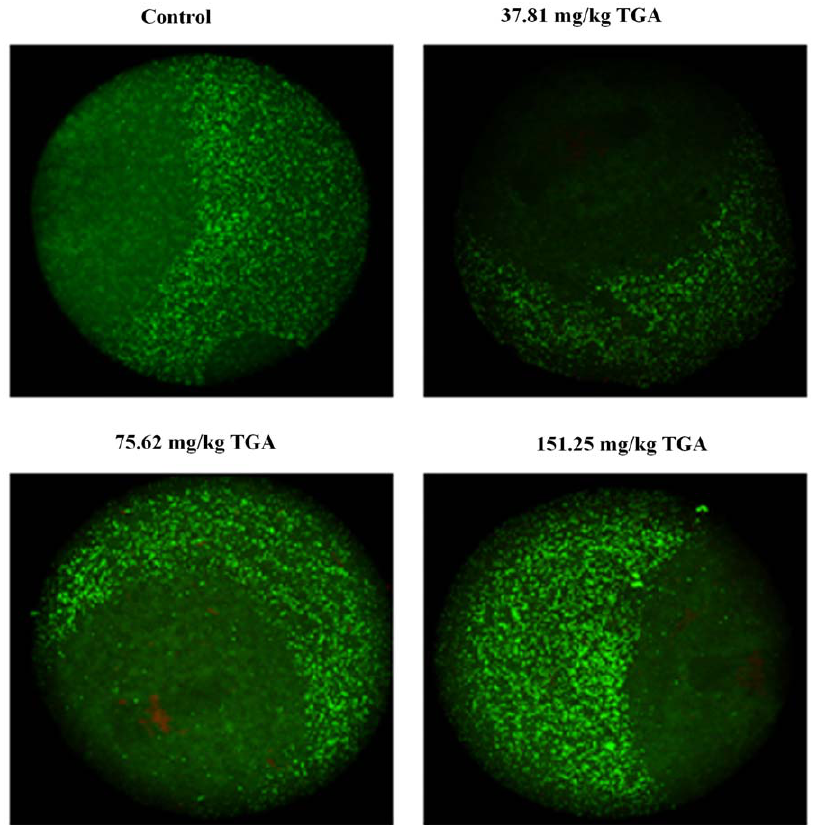
Figure 4. Effect of TGA on the distribution of cortical granules (CGs) of in vivo matured oocytes (laser scanning confocal microscopic images, 6 600). The oocytes were stained with fluorescein isothiocyanate-Lens culinaris agglutinin. The green fluorescence shows the CG distributions.